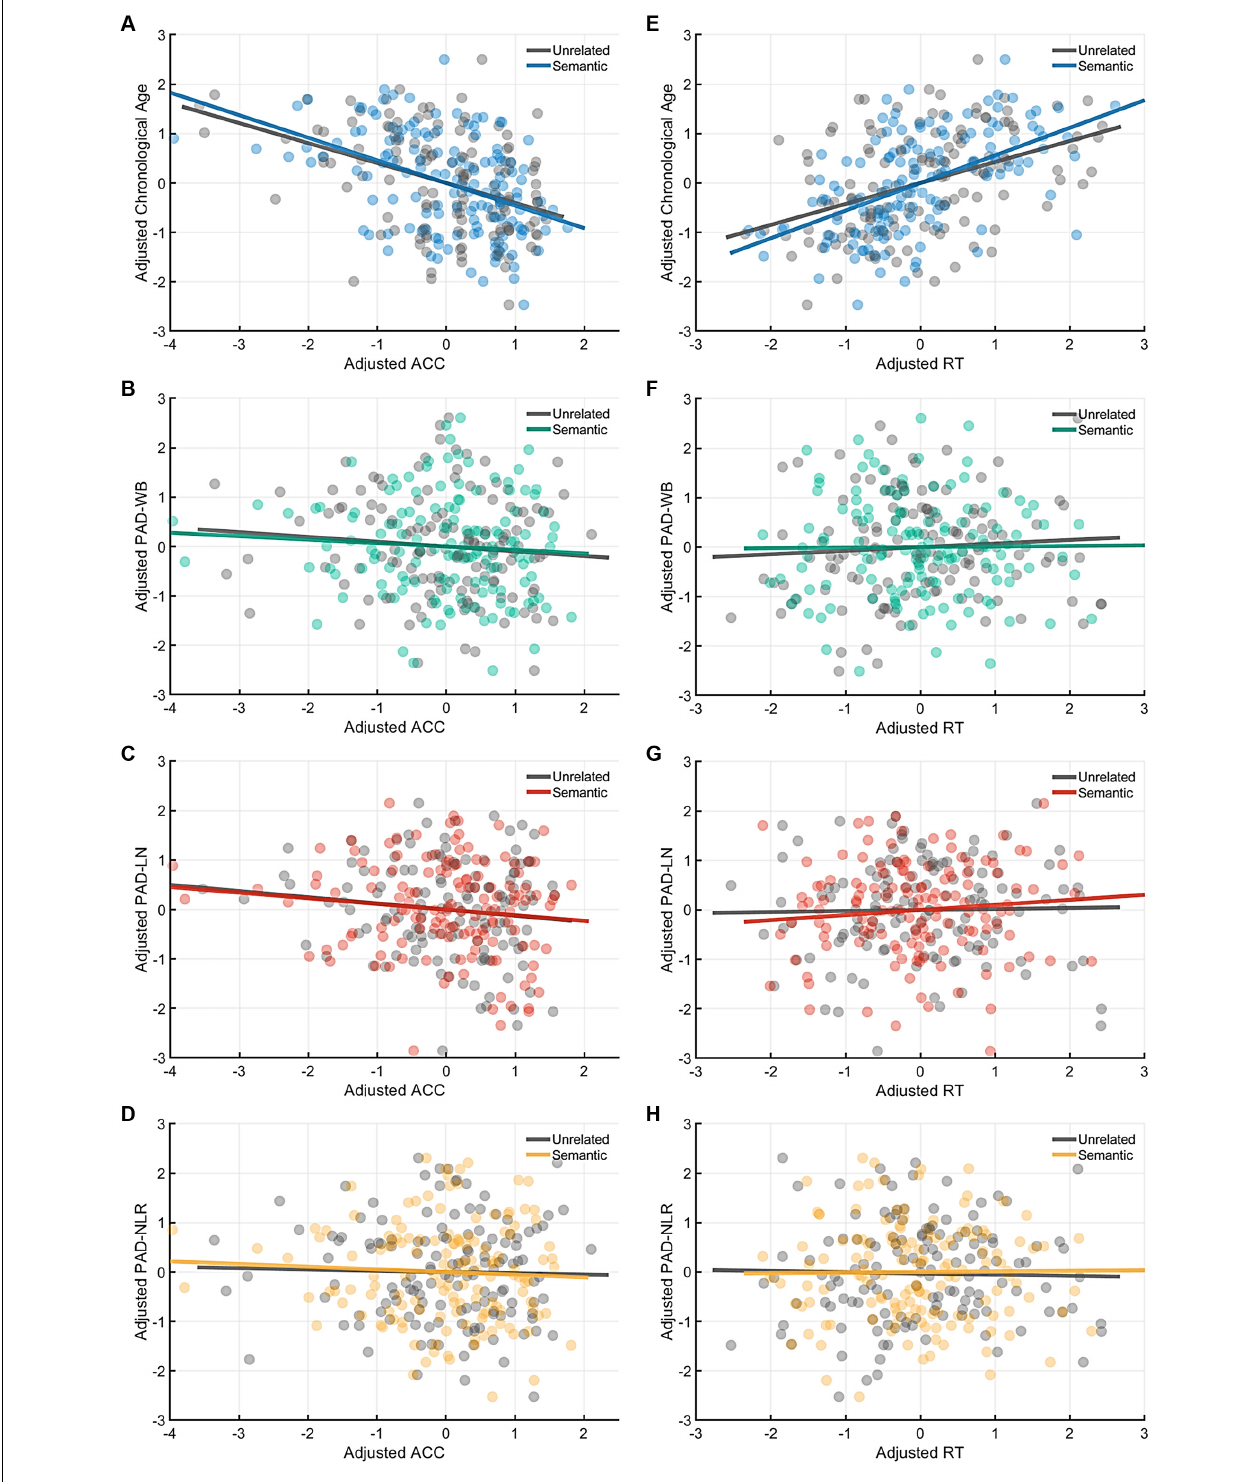
FIGURE 5 | Partial correlation of the cognitive indices (ACC and RT) at the semantic-priming condition with age measures (chronological age and brain age). Under the semantic-related priming condition, chronological age was significantly correlated with ACC (A) , but no brain age measures were associated with ACC. (B–D) Likewise, only chronological age was significantly correlated with RT (E) , whereas all brain age measures were not correlated with RT (F–H) . Abbreviation: ACC, accuracy; RT, response time; PAD, predicted age difference; NLR, non-language regions; LN, language network; WB, whole brain.